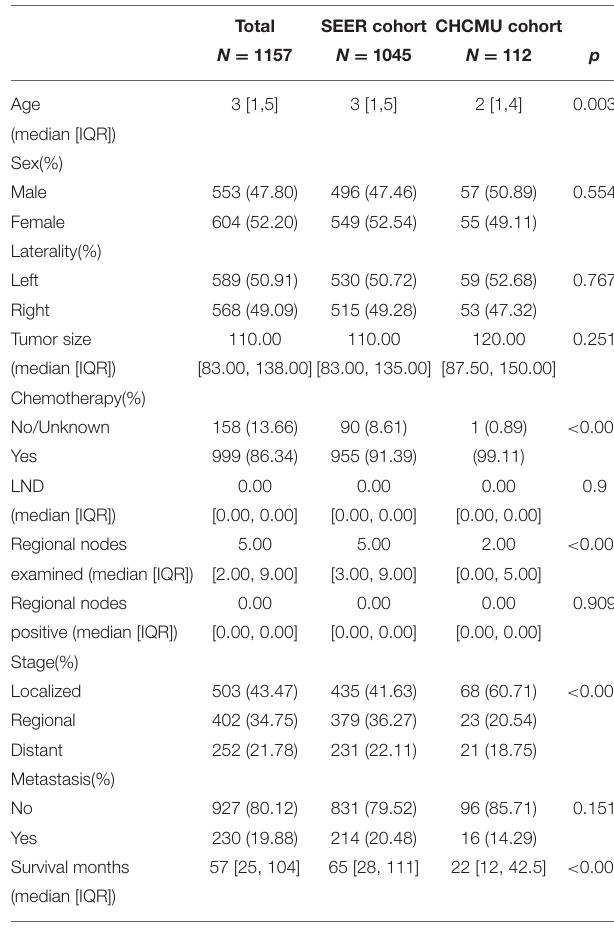
TABLE 1 | Clinicopathological characteristics of children with WT in SEER database.